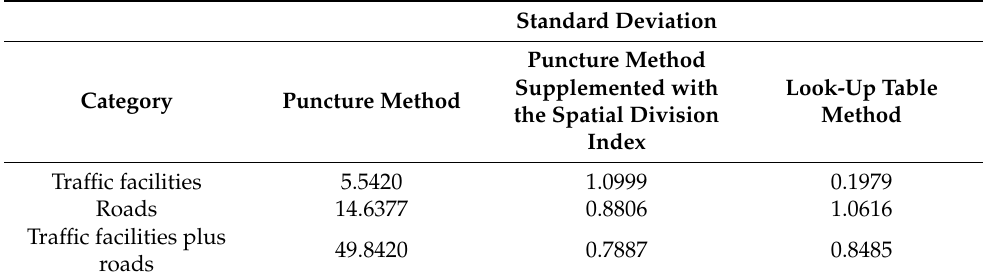
Table 7. Standard deviation of the eight-segment layers for the three methods.